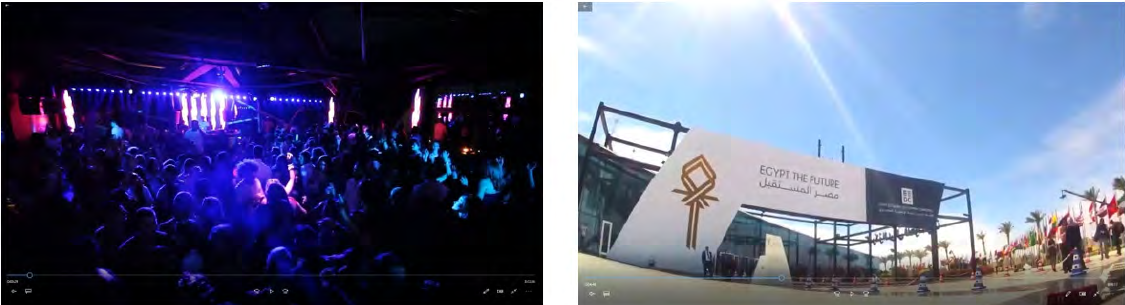
Figure 16. Events with different purposes used in Egypt (New Egypt Old Friends, 2016) People